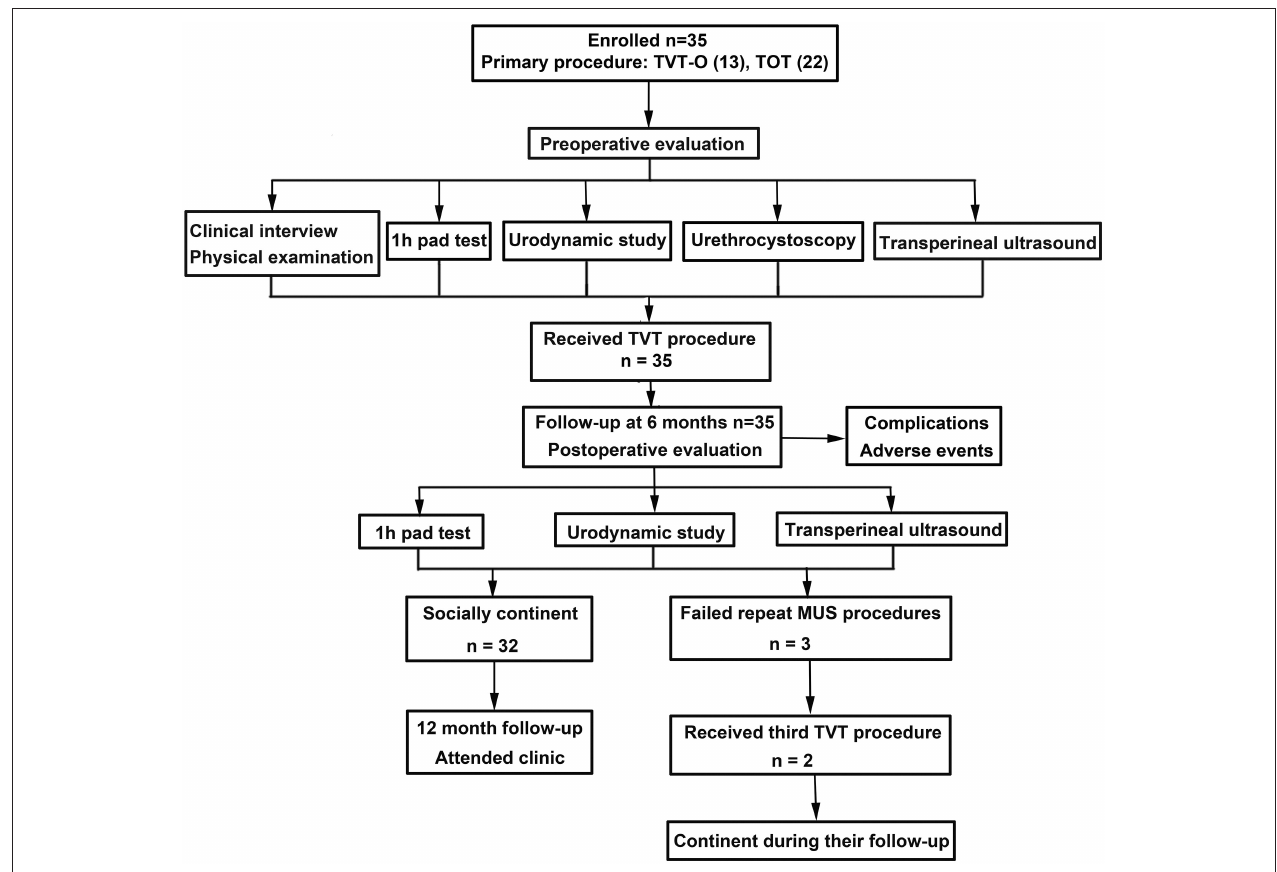
FIGURE 2 | Flow of patient management and follow-up.